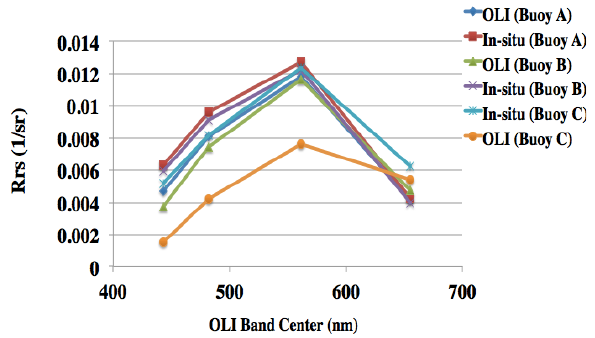
Figure 4. Comparison of the OLI-derived 𝑹 𝒓𝒔 and spectrally resampled in-situ 𝑹 𝒓𝒔 at three stations (Buoys). Overall, there is a very good agreement between OLI retrievals and the in-situ measurements.